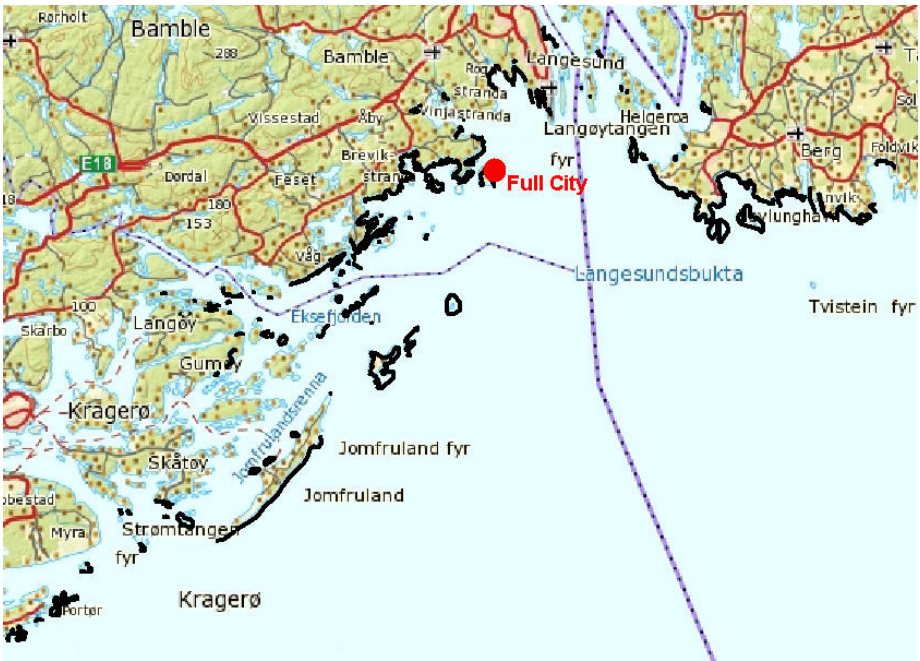
Fig. 5. Observations of the spreading of oil after the full city incident. All records regardless of amount of oil are included. Oil was also observed at Risør (23km southwest of Jomfruland just outside the map) and Ruaker, near Grimstad (about 75km southwest of Jomfruland).